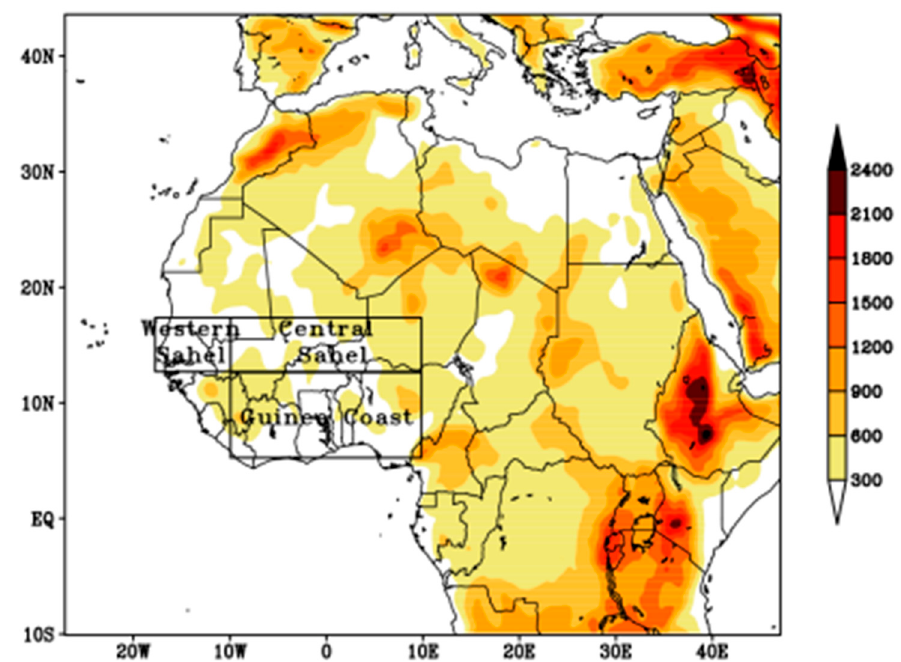
Figure 1. Topography (m) of the simulation domain (West Africa) and the considered subdomains (western Sahel, central Sahel and the Guinea Coast) from the Regional Climate Model RegCM4.